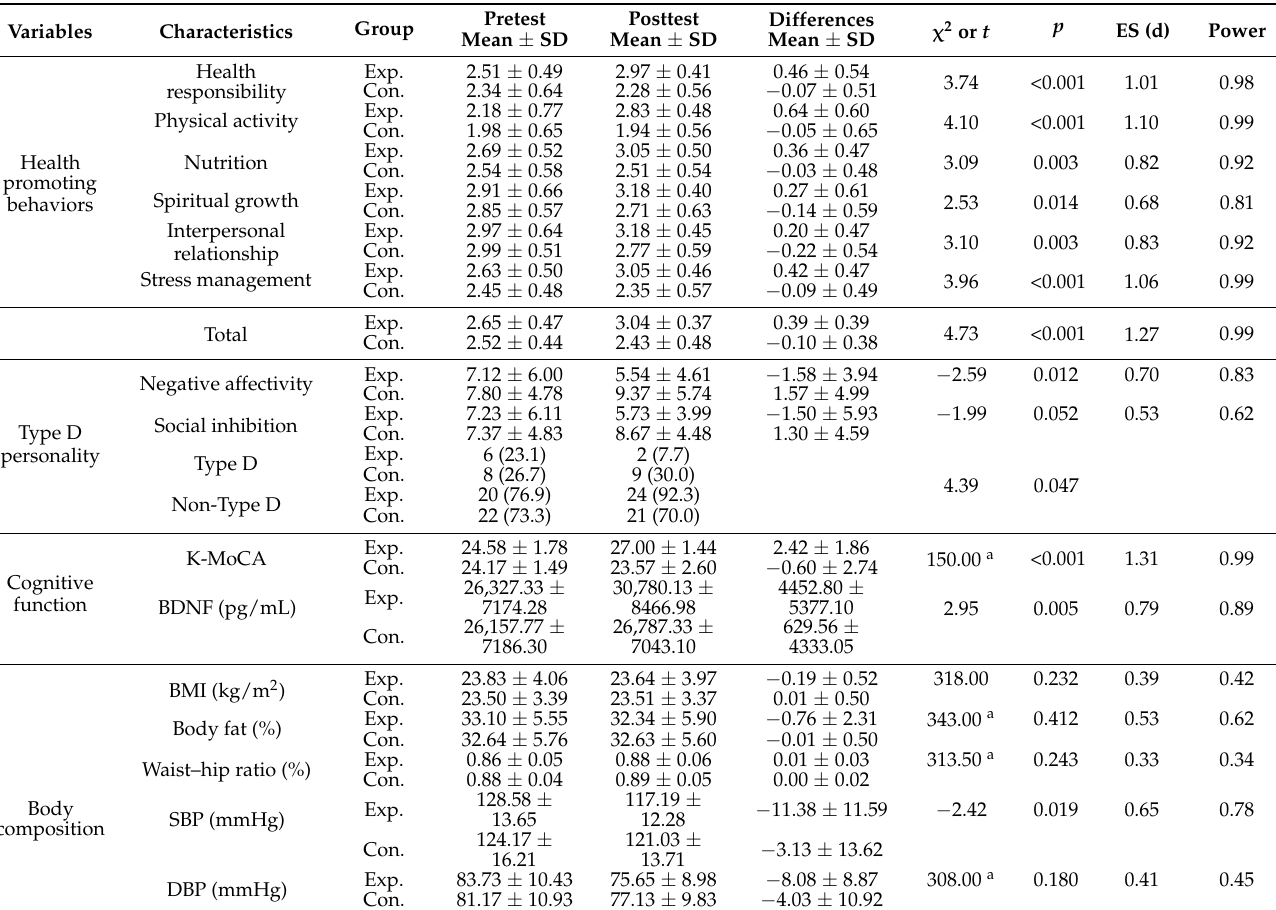
Table 3. Effects of the lifestyle interventions ( n =